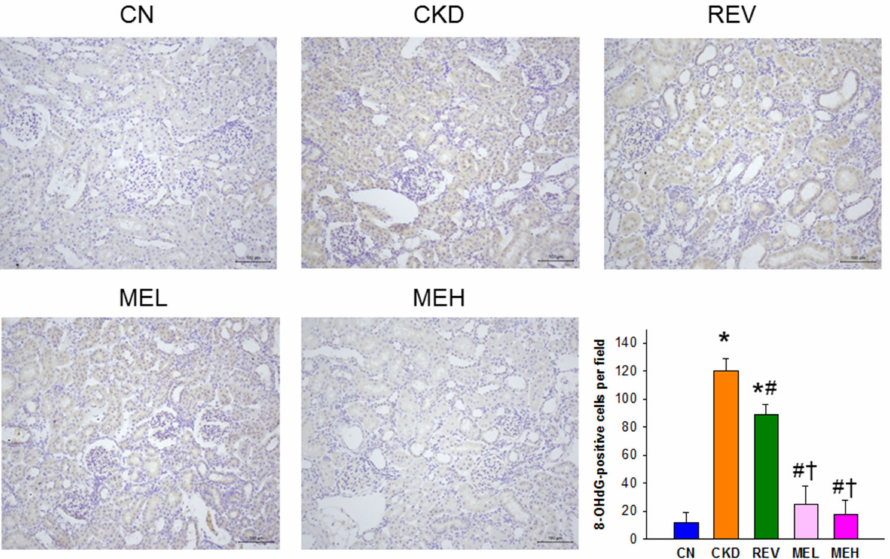
Figure 1. Light micrographs illustrating immunostaining for 8-OHdG in the rat kidneys (200 × ). n = 8/group; * p < 0.05 vs. CN; # p < 0.05 vs. CKD; and † p < 0.05 vs.